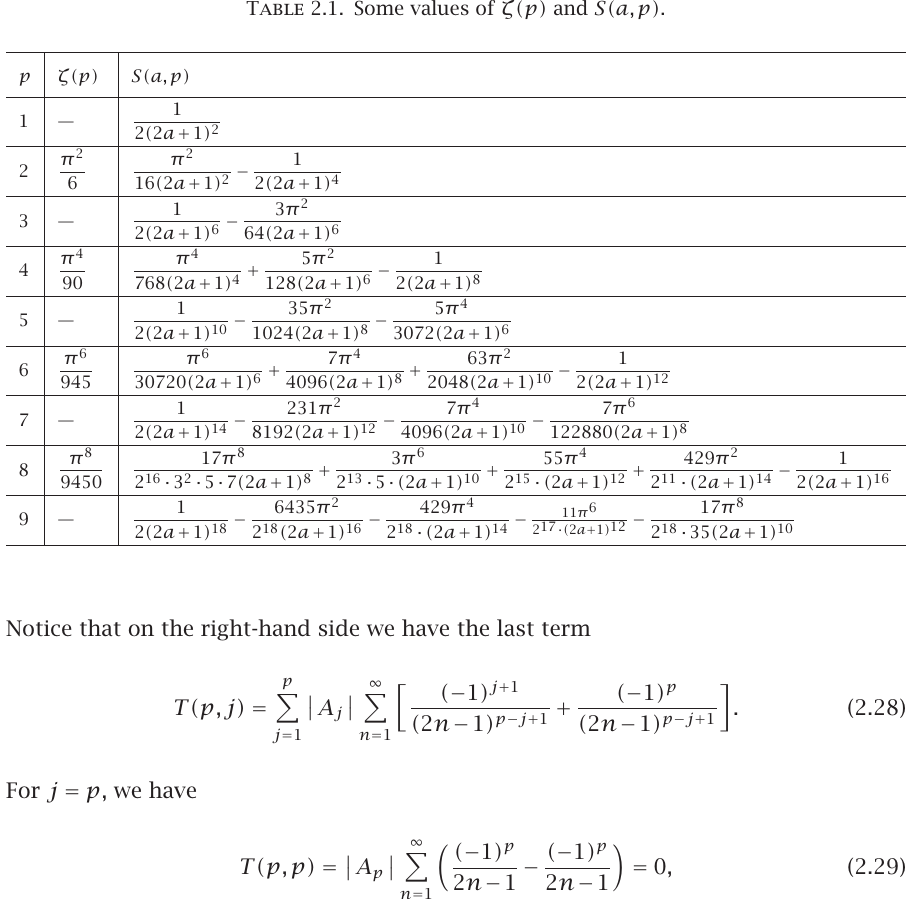
Table 2.1 . Some values of ζ(p) and S(a,p)